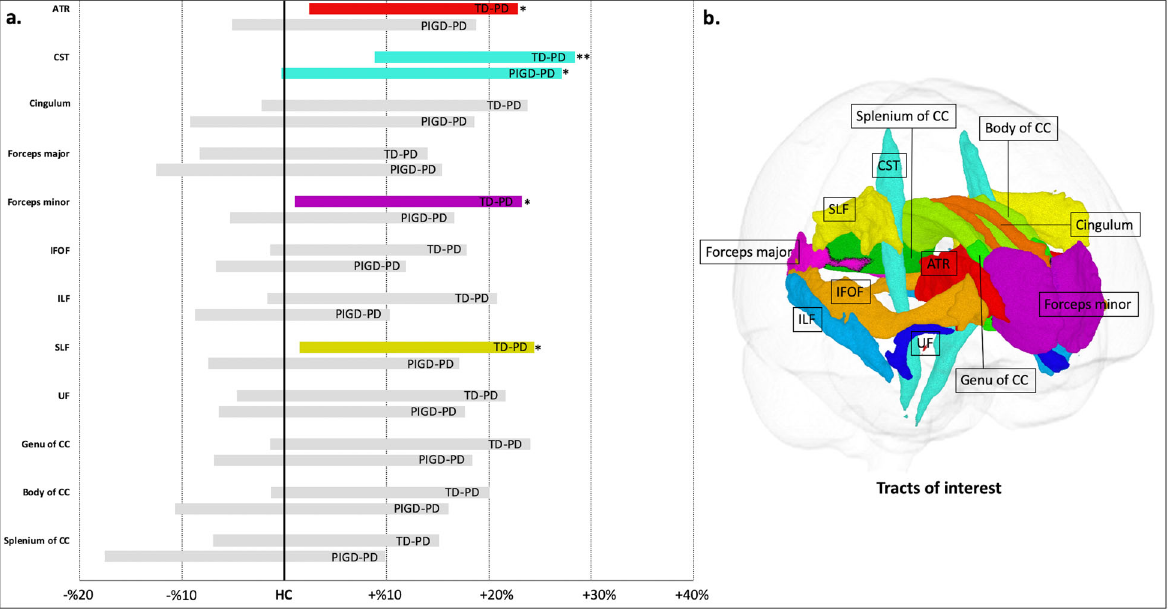
Fig. 2 White matter tract of interest analysis. a Increases (displayed in color; * P = 0.0045 − 0.05, ** P < 0.0045) in a combined fi ber density and cross section (FDC) metric in patients with TD-PD and PIGD-PD visualized as percentage difference from the HC. b Tracts of interest. ATR anterior thalamic radiation, CC corpus callosum, CST corticospinal tract, IFOF inferior fronto-occipital fasciculus, ILF inferior longitudinal fasciculus, PIGD-PD patients with postural instability and gait disorder Parkinson ’ s disease, SLF superior longitudinal fasciculus, TD-PD patients with tremor-dominant Parkinson ’ s disease, UF uncinate